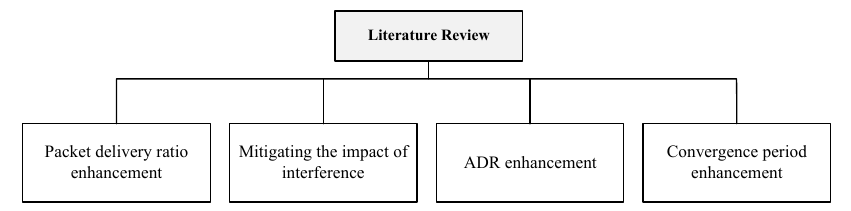
Figure 4. Categorization of the literature